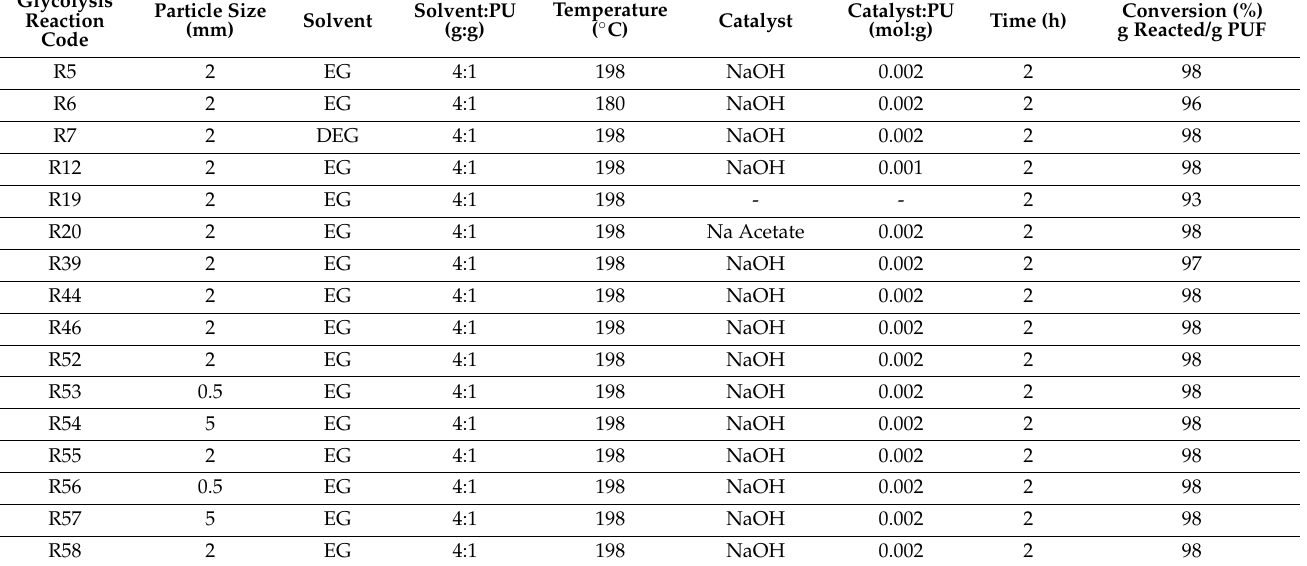
Table 2. Conditions of the glycolysis reactions,